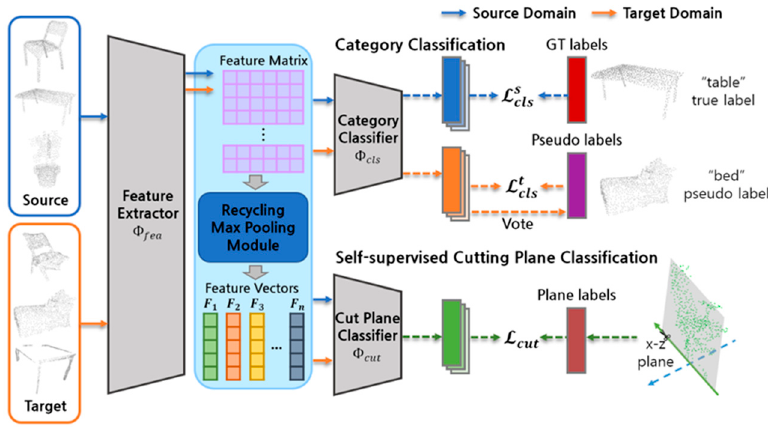
Figure 2. Overview of the proposed domain adaptive point cloud classification model.